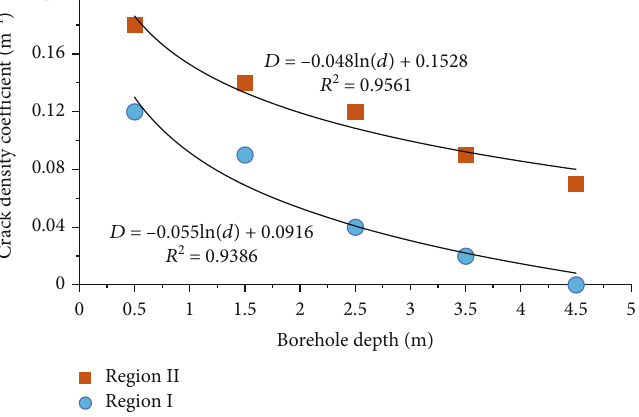
D = –0.048ln( d ) + 0.1528 R 2 = 0.9561